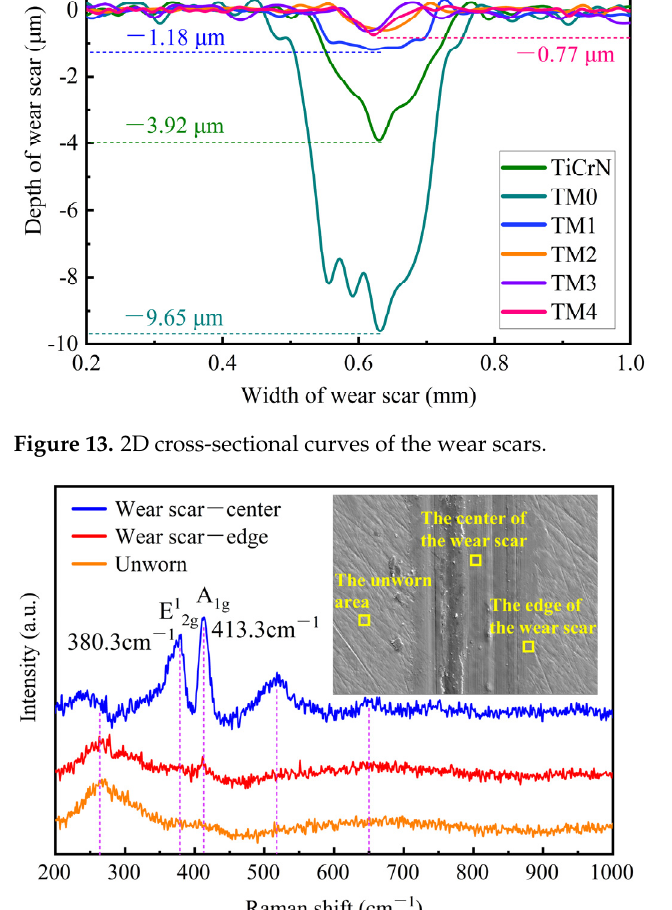
Figure 14. The Raman characterization of the unworn region and wear scar of the TM3 coating.